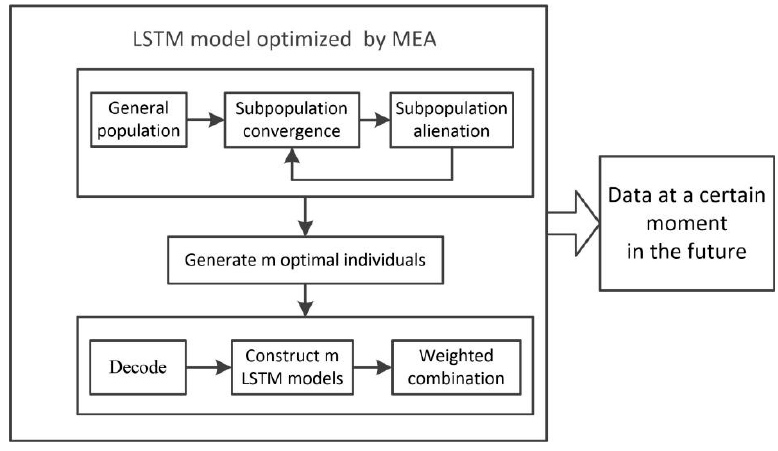
Figure 5. Longitudinal predictive control model.